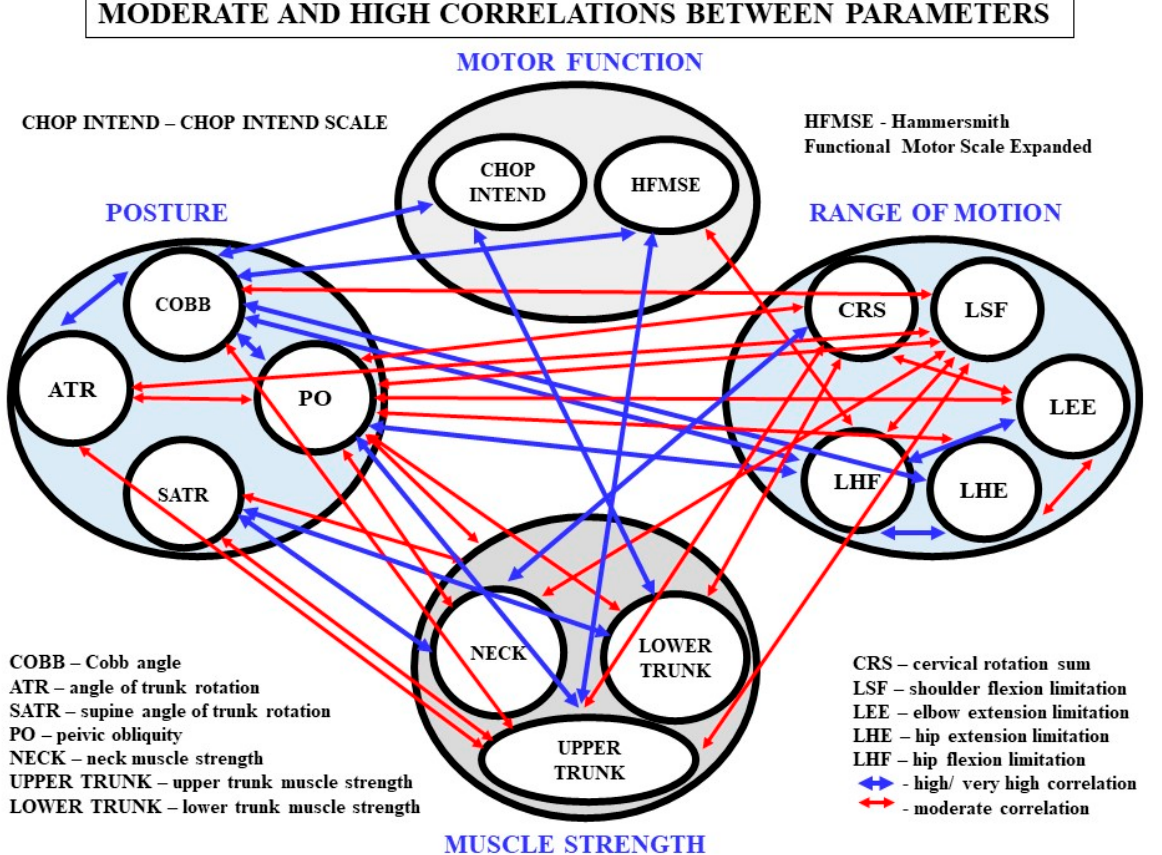
Figure 4. Graphical interpretation of moderate, high, and very high correlations between the examined parameters; a total of 14 high/very high correlations and 22 moderate correlations between motor function, muscle strength, range of motion, and postural parameters were observed in the study group.